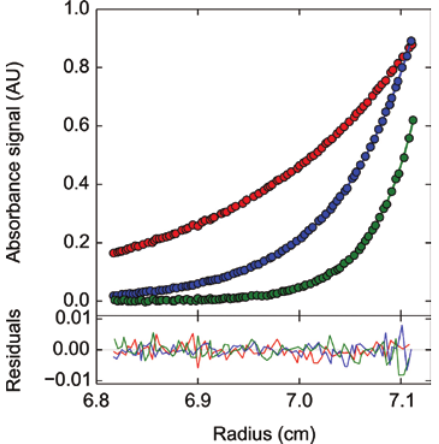
Figure 4: Sedimentation equilibrium profiles for MSP1E3D1/POPC empty nanodiscs at 10 ° C plotted as a distribution of the absorb- ance at 280 nm versus radius. Absorbance sedimentation data were collected at 10,000 (red), 15,000 (blue), and 20,000 (green) rpm and a loading concentration corresponding to 0.68 A